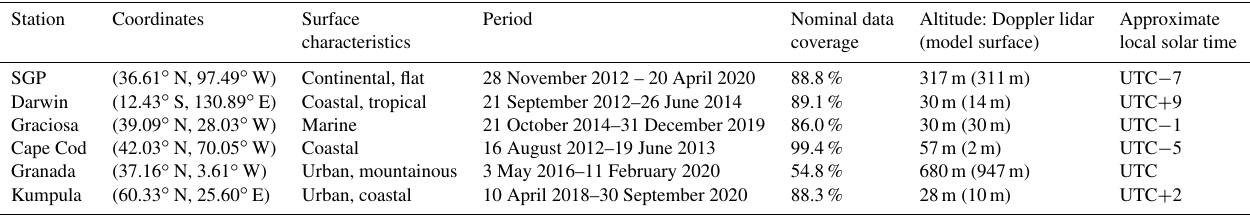
Table 1. Measurement stations and observation periods. Nominal data coverage refers to the proportion of time during the measurement periods that both Doppler lidar (DL) and IFS data are available before filtering for data quality. Station